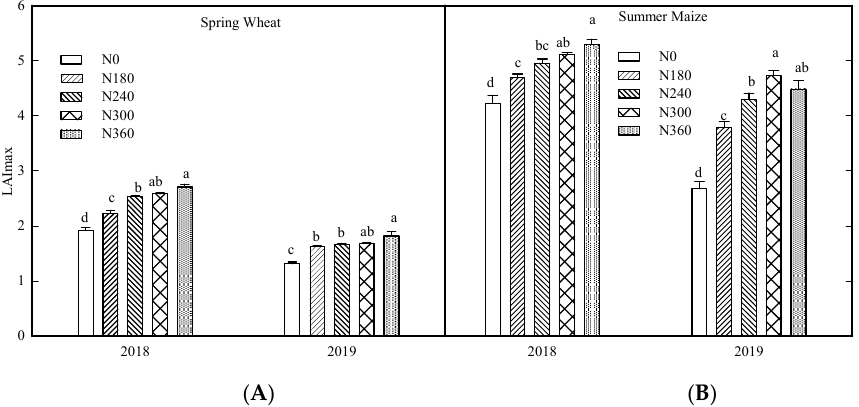
Figure 4. Effects of the nitrogen application rate on the spring wheat (A) and summer maize (B) maximum leaf area index at the flowering or silking stage. Note: The lowercase letters above bar graph indicate the significant differences at p < 0.05 levels.